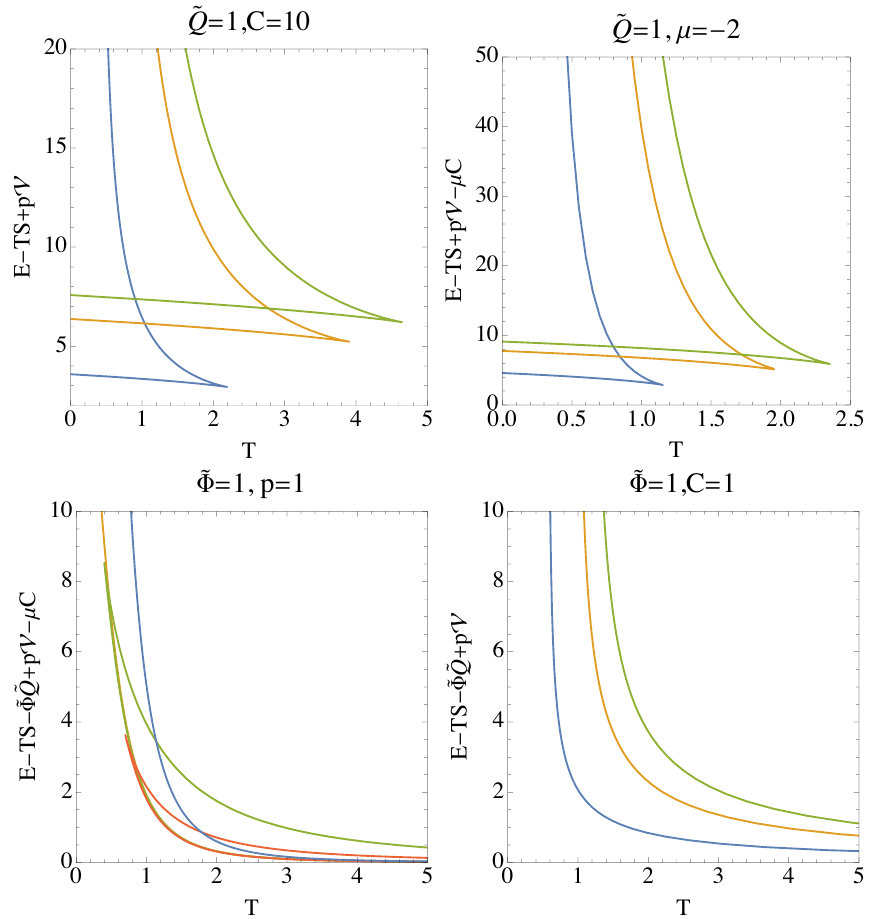
Figure 4 . The free energies of other ensembles plotted against temperature in d = 4 , corresponding to ensembles at fixed ( ˜ Q, p, C ) , ( ˜ Q, p, µ ) , (˜Φ , p, µ ) and (˜Φ , p, C ) (from left to right). In the top left and right diagrams the free energies are plotted for p = 1 (blue), p = 10 (orange) and p = 20 (green). On the bottom left, the free energy of the fixed (˜Φ , p, µ ) ensemble has qualitatively different behaviour for µ ≤ 0 and µ > 0 . The former is single branched with an asymptote at T = 0 , while the latter is double branched with a “tip” corresponding to a maximum ˜Φ and minimum T ; the parameters used are µ = − 10 (blue), µ = 0 (orange), µ = 1 / 20 (green) and µ = 1 / 5 (red). On the bottom right, the free energy plot for fixed (˜Φ , p, C ) has a single branch with an asymptote at T = 0 ; the parameters used are p = 1 (blue), p = 5 (orange), p = 10 (green). These four ensembles do not display phase